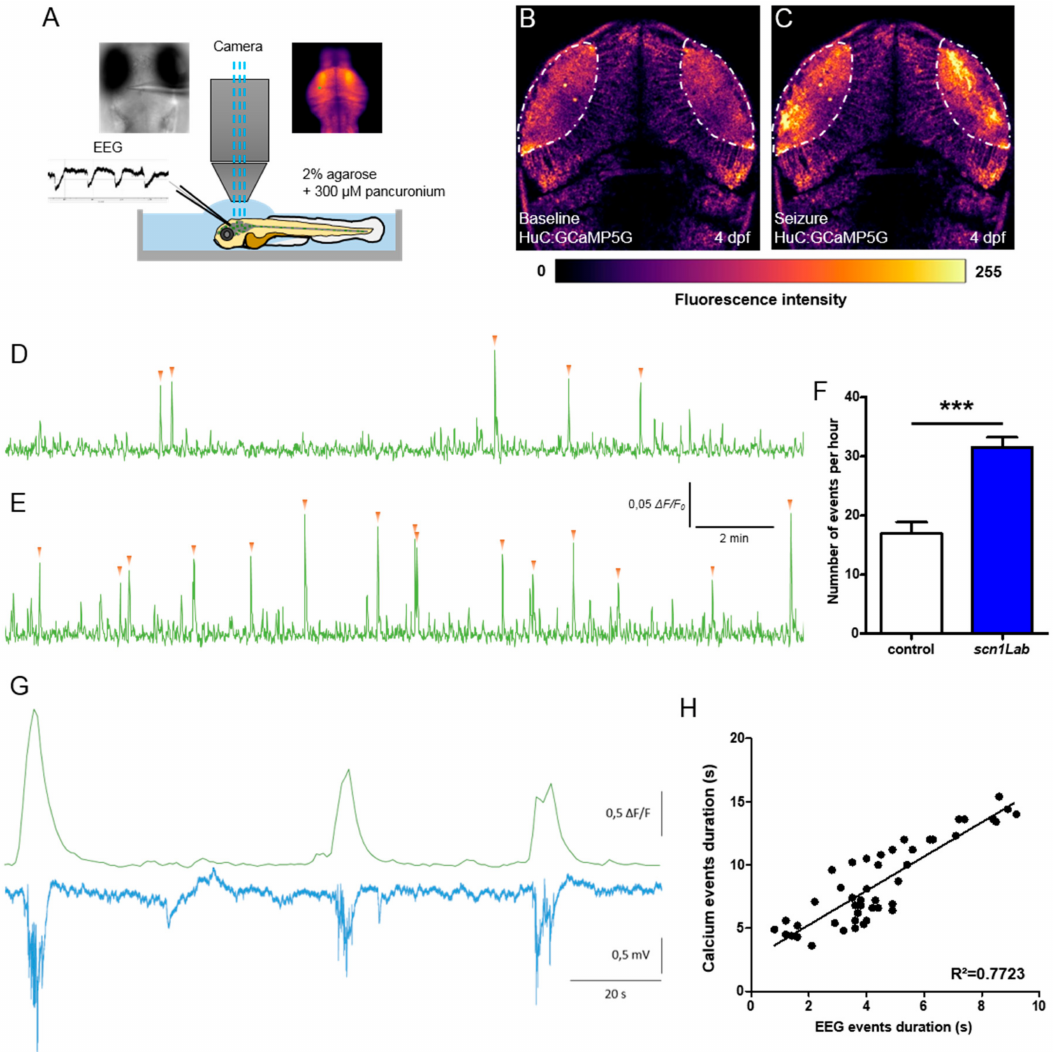
Figure 1. Correlation between LFP and calcium activity in scn1Lab model. ( A ) Schematic of the experimental setup to simultaneously record local field potential and calcium activity of a larval zebrafish brain. ( B , C ) Calcium images showing respectively the baseline activity ( B ) and the seizure activity ( C ). The fluorescence intensity is color-coded as shown in the color bar below the images. ( D , E ) Representative 20 min calcium recording of immobilized and paralyzed 4 dpf control ( D ) ( N = 9) and scn1Lab ( E ) ( N = 9) larvae. Each calcium event is shown with an orange arrowhead. ( F ) Number of events, calcium increases greater that 0.04 ∆ F / F 0 amplitude, during 1 h recording. ( G ) Representative LFP, recorded in the left neuropil of the optic tectum, and calcium traces, from the optic tectum, of a paralyzed and immobilized 4 dpf scn1Lab larva. ( H ) Correlation between LFP and calcium events duration ( n = 46). N = number of larvae and n = number of events. Error bars on all graphs represent standard error of the mean (SEM). ***, p < 0.001. p -value was determined using Student’s unpaired t